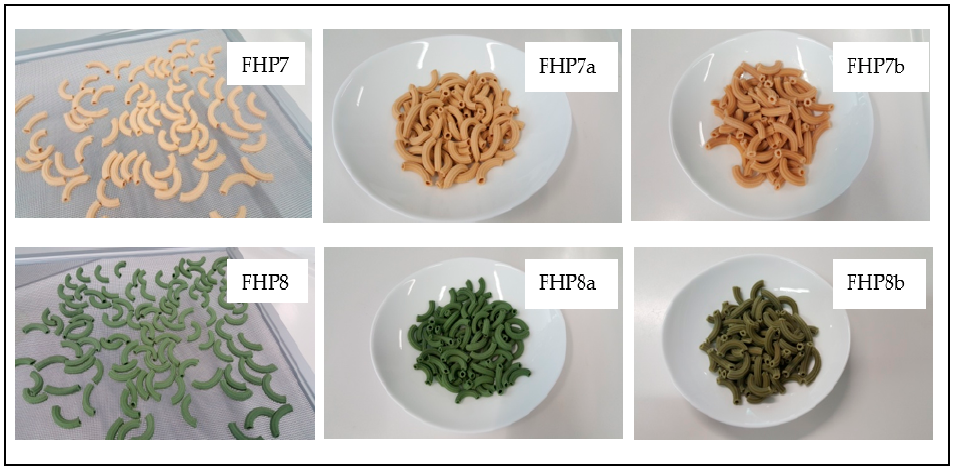
Figure 1. Raw (a) and cooked pasta (b) produced using formulation 7 (FHP7) and 8 (FHP8).